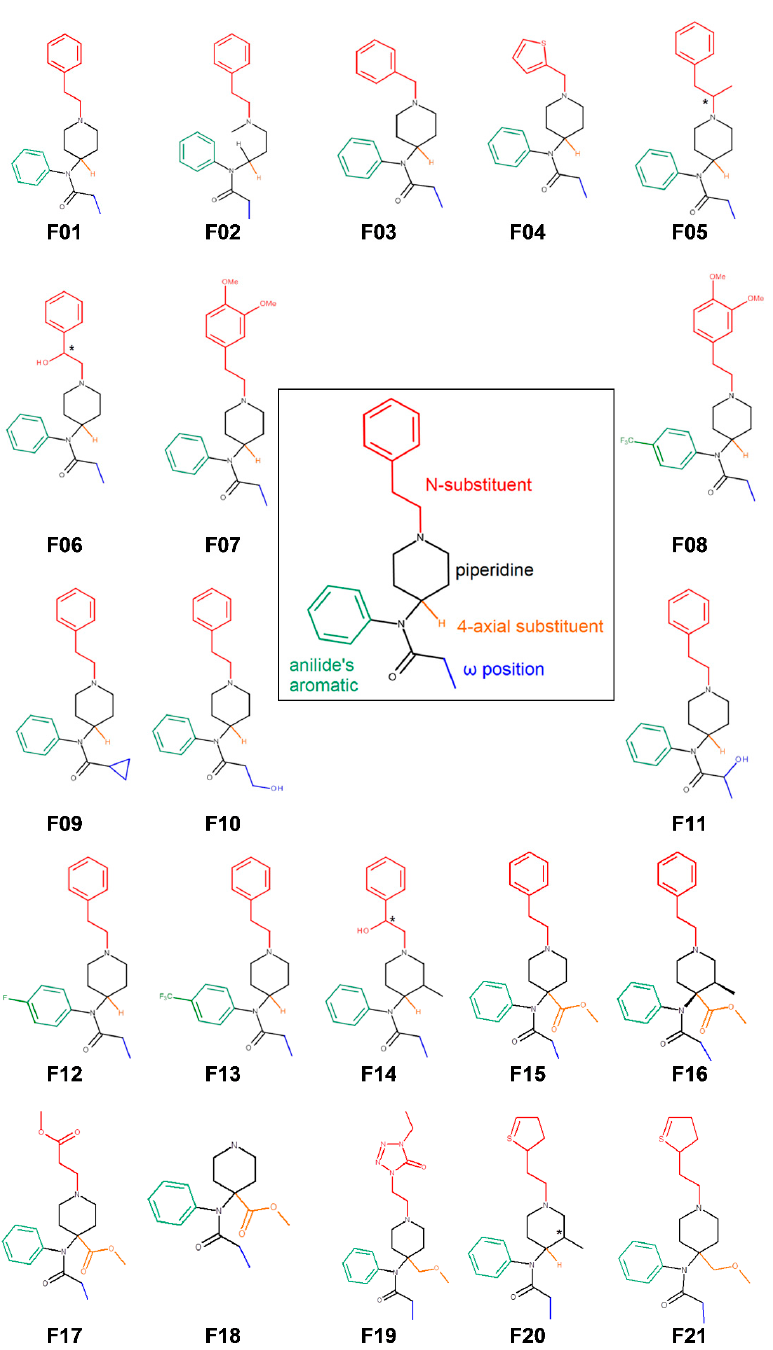
Figure 1. Structures of 21 fentanyl derivatives under the study and a logical disassembly of the parent fentanyl into structural elements subject to variation in the set.